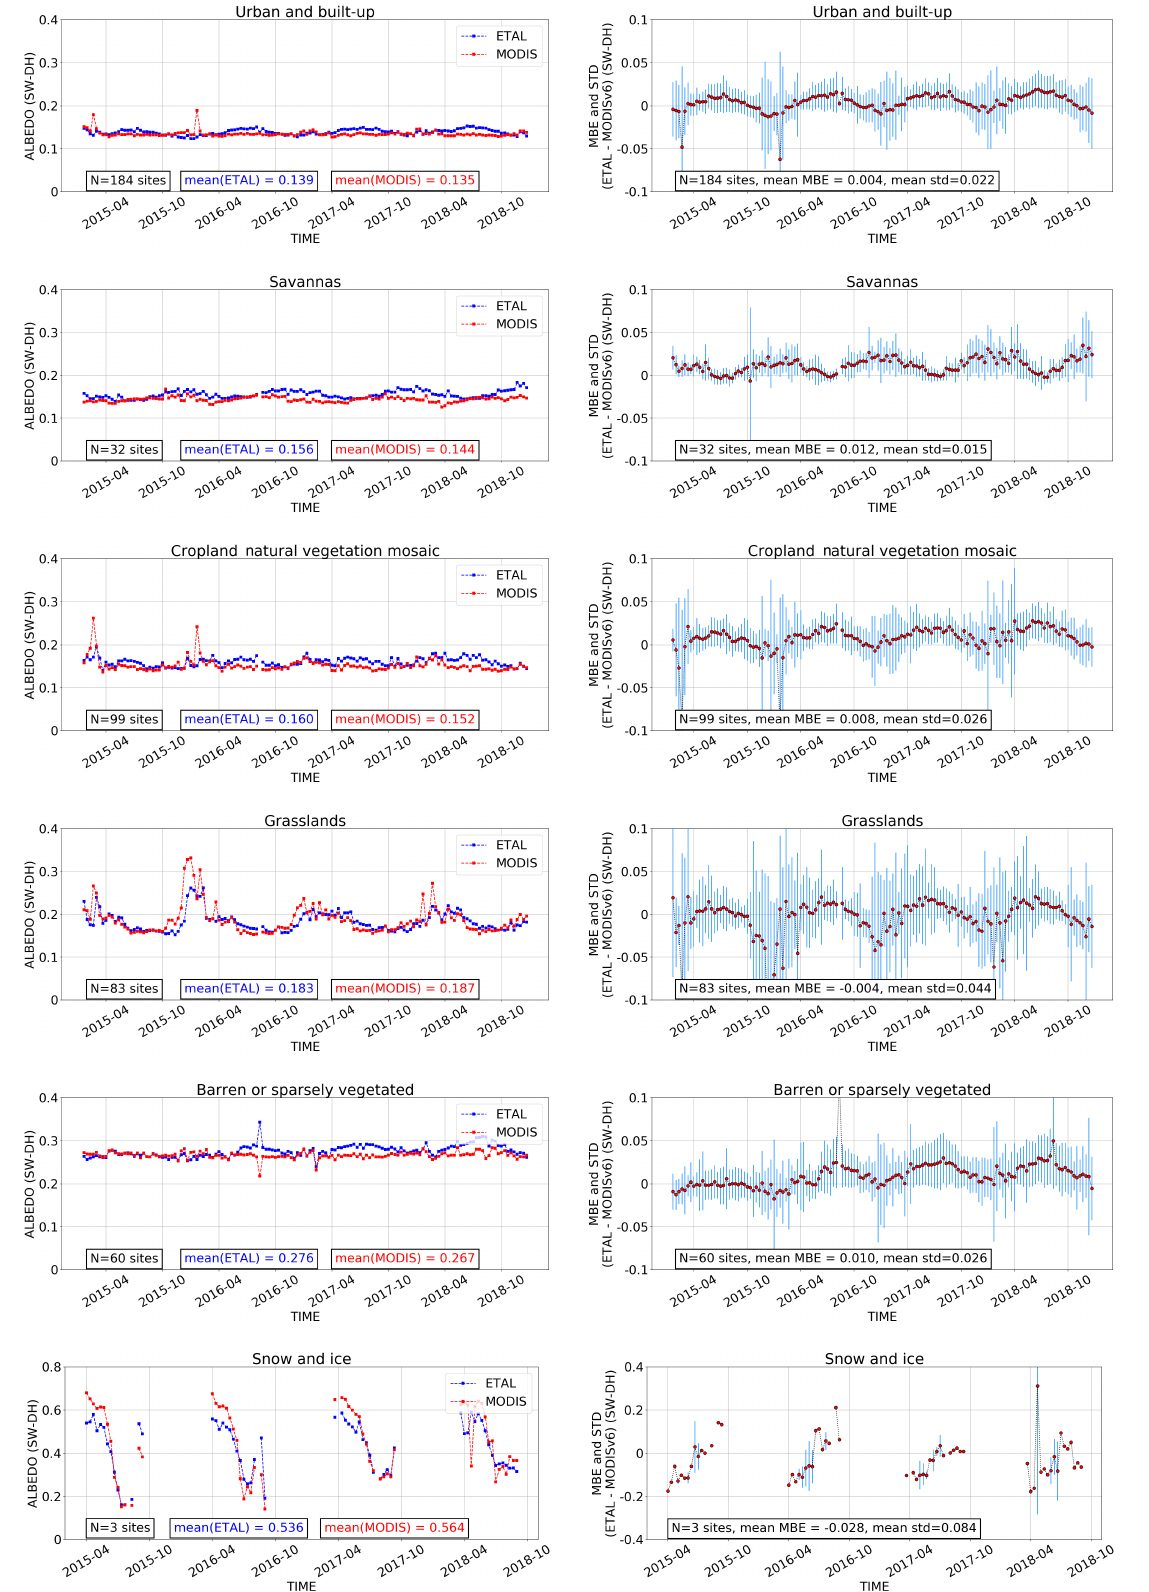
Figure A6. Time series of ETAL versus MODIS for the other 12 land cover types over the period